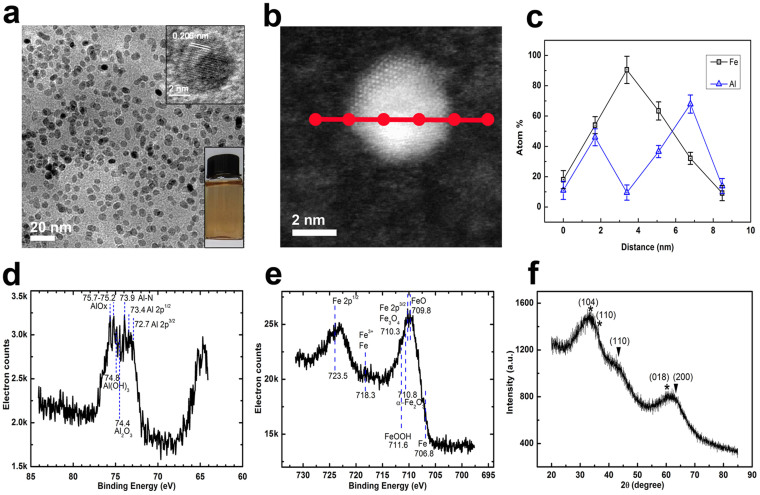
Wide-viewed TEM image (a), HR-TEM image of one single particle (a: inset), STEM-HAADF image of one single particle (b), point-by-point EDX scanning of one single particle (c), high energy resolution XPS for Al (d), high energy resolution XPS for Fe (e) and XRD (f) of FeAl@Al(1-x)FexOy nanohybrids synthesized using all NMP-phased reaction systems at a resident time of 0.73 ~ 0.88 s in microfluidic channel and 20 min in the cooling receiver.Right-bottom inset in Fig. 2a is the NPs solution. JCPDS No for XRD analysis: bcc Fe, 6-0696; α-Al2O3, 46-1212; γ-Al2O3, 10-0425. In XRD (f), : the corresponding metallic phases; *: the corresponding metal oxides.